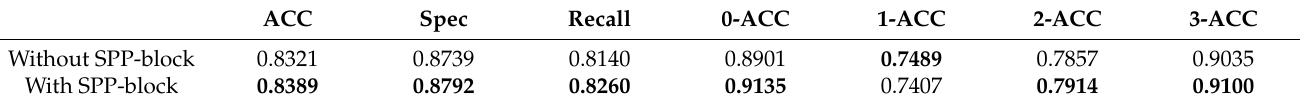
Table 3. Comparative experimental results of